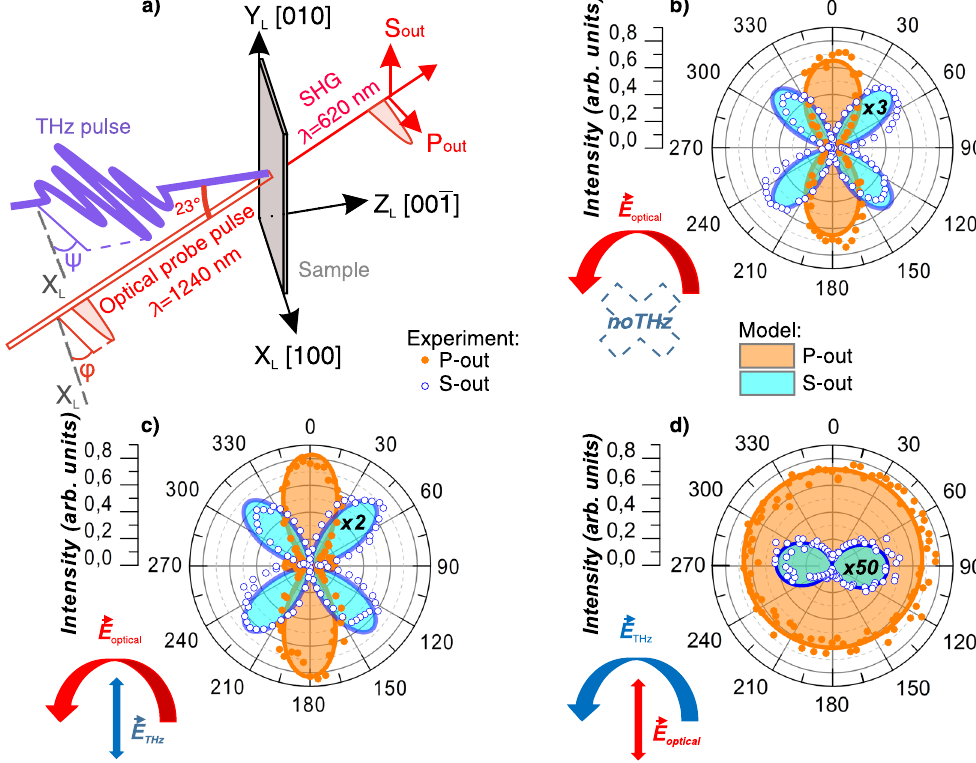
Figure 1. Experimental geometry and polarization diagrams of the SHG intensity for various experimental geometries. ( a ) Experimental geometry. The axes of the chosen laboratory frame X L , Y L , Z L correspond to [100], [010] and [ 001 ] crystallographic directions, respectively. ϕ - the angle between the electric field of near-infrared probe and the X L -axis. ψ - the angle between the electric field of the THz pump pulse and the X L -axis; ( b ) dependence of the SHG signal on ϕ without any THz pump; ( c ) dependence of the SHG signal on ϕ when the THz field is applied parallel with respect to the X L -axis. The polarization of the SHG signal was set either in the P out or S out -state; ( d ) dependence of the SHG signal on ψ when the probe polarization was set to the P-state ( ϕ = 0). The polarization of the SHG signal was set either in the P out or S out -state. Dots correspond to experimental data and lines are fits (calculations see in Supplementary Information). Values for S-state multiplied by 3, 2 and 50 for ( b – d )